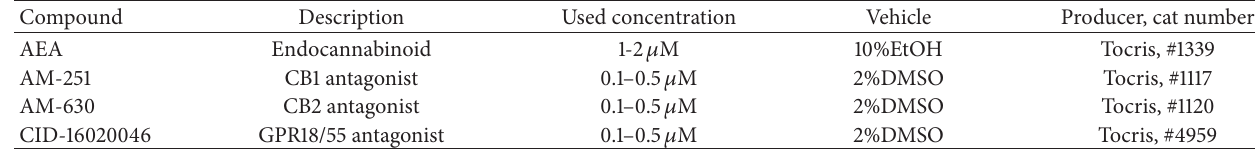
Table 1: Compounds interacting with the endocannabinoid system used in the